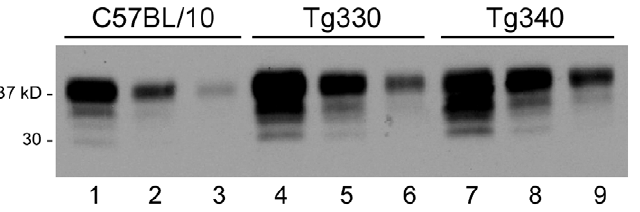
Figure 1. Immunoblot detection of PrPsen from C57BL/10 and transgenic mice. Blot was developed using anti-PrP monoclonal antibody D13 and enhanced chemiluminescence exposure for 1 minute. Lanes 1-3 show brain PrP-170N expression level in a C57BL/10 mouse, lanes 4-6 and lanes 7-9 show brain PrP-170S expression in Tg330 and Tg340 mice. For each mouse, three lanes beginning on the left were loaded with 0.5, 0.25 and 0.125 mg tissue equivalents, respectively. Comparison of these groups of samples suggested 2-3-fold greater PrP expression in the transgenic mice versus C57BL/10 mice. Several different individual transgenic mouse brains were also studied, and results confirmed the data presented here. Tg330 and Tg340 also expressed detectable levels of PrPsen in kidney, cecum, adrenal gland, heart, spleen and skeletal muscle (immunoblots not